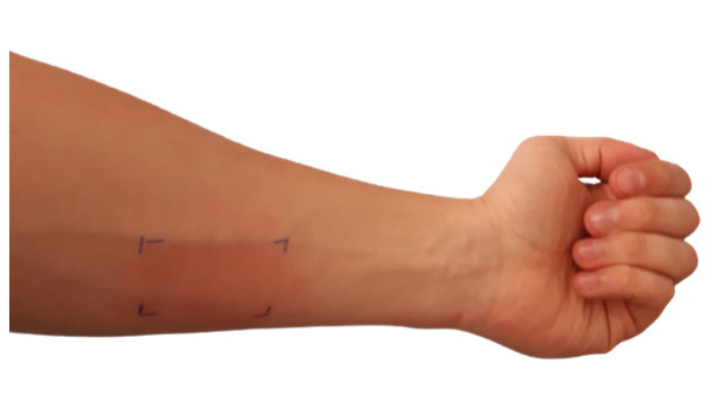
Figure 10. Forearm with marked region of interest.